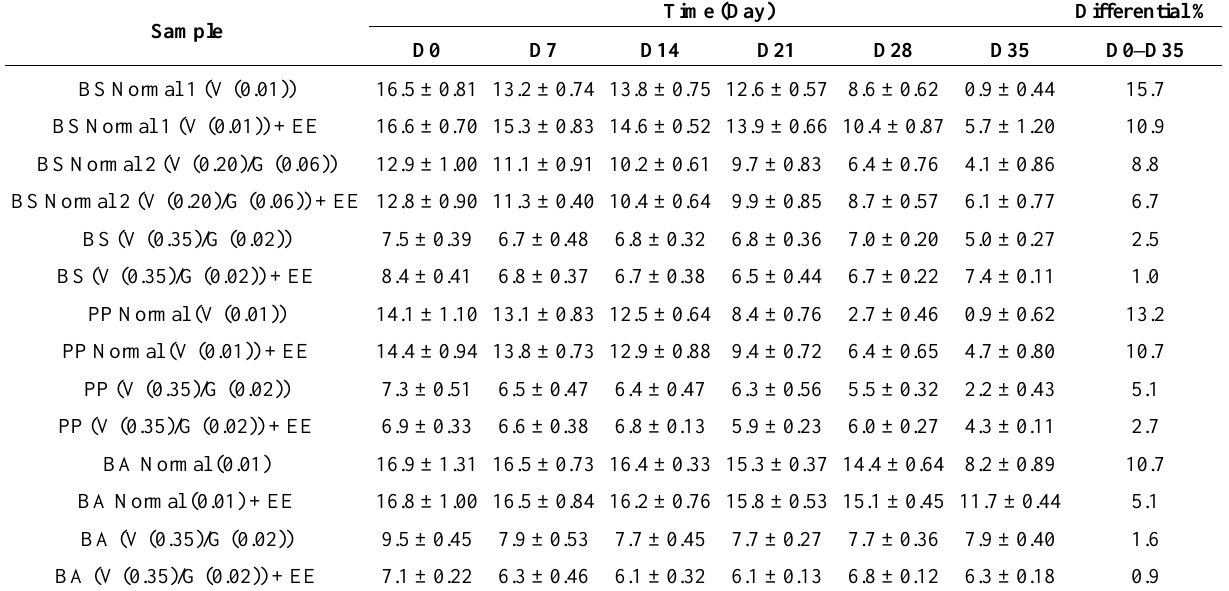
Table 5. Mean O levels found in all samples over shelf life study (including standard 2 deviation). V—represents the level of vacuum pressure (MPa); G—represents the level of gas flush